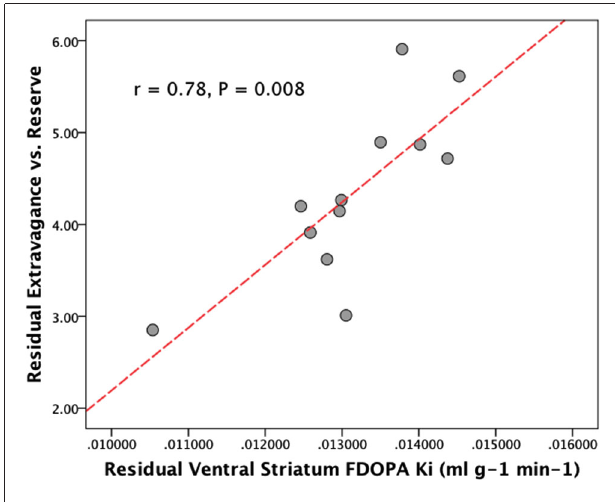
FIGURE 1 | Plot showing the partial correlation between ventral striatal dopamine synthesis capacity (FDOPA K i ), and disinhibitory personality traits (NS3, Extravagance vs. reserve) controlling for age and Harm Avoidance.